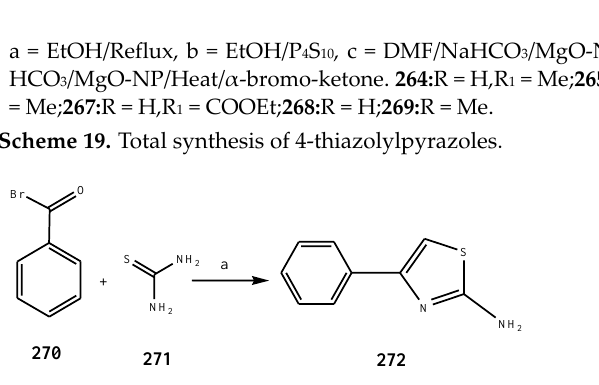
Scheme 20. Synthetic routes of substituted